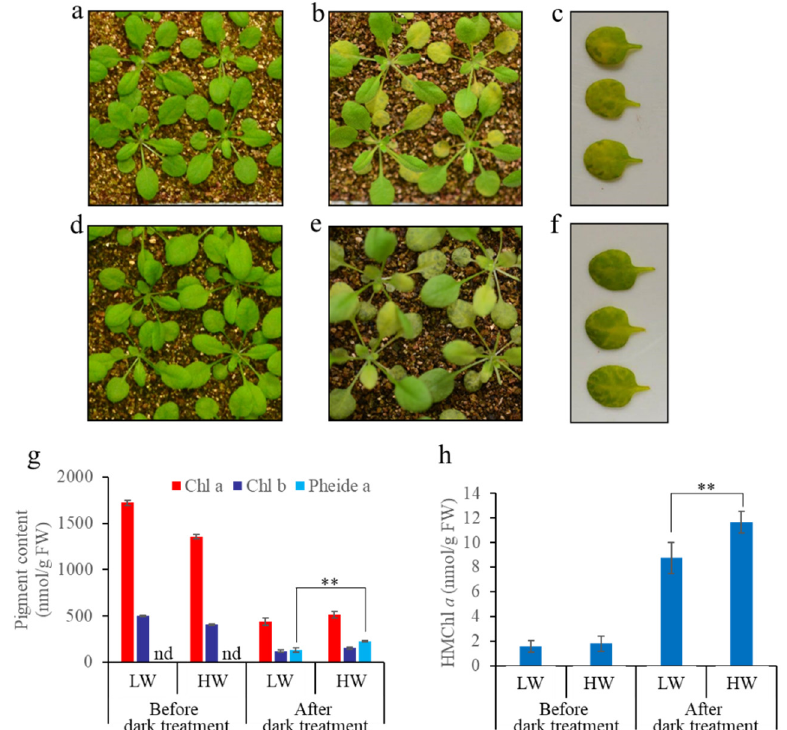
Figure 3. Phenotypic and Chl metabolic characterization of WT plants grown in soil with different water content during dark-induced senescence. ( a–c ) The phenotype of WT plants before ( a ) and after ( b , c ) 7 days of dark treatment. Plants were grown in soil with a low water content. ( c ) No. 5–6 leaves were detached from dark-treated WT plants. ( d–f ) The phenotype of WT plants before ( d ) and after ( e , f ) 7 days of dark treatment. Plants were grown in soil with a high water content. ( f ) No. 5–6 leaves were detached from dark-treated WT plants. ( g ) Chl and Pheide a contents in No. 5–6 leaves before and after intact plant incubation in darkness. ( h ) HMChl a content of leaves No. 5–6 before and after intact plant incubation in darkness. Values are the mean ± SD of three independent experiments. LW indicates soil with a low water content (approximately 70% moisture), and HW indicates soil with high water content (saturated moisture). Asterisks indicate significant differences (Student’s t -test, ** p < 0.01). nd indicates that the pigments content was not detected.